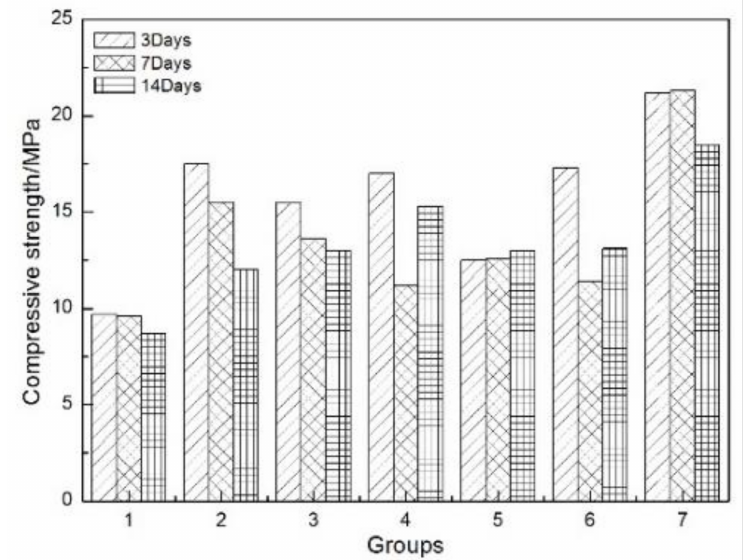
Figure 5. Compressive strength of 35% added sand.